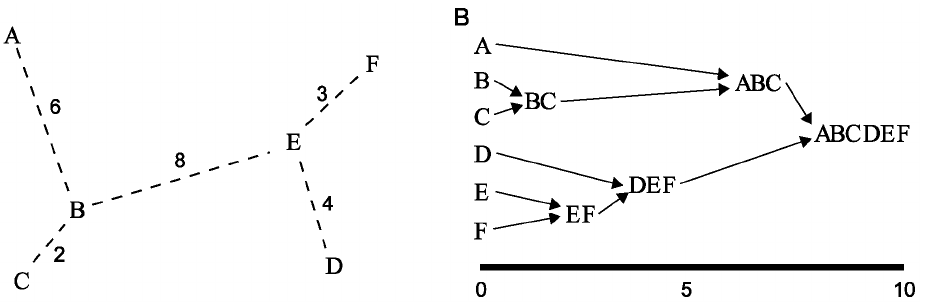
Figure 2. Graphical representation of hierarchical clustering. Hierarchical clustering sequentially clusters together elements of a set, based on inter-element distances. (A) Representation of a set of six elements. Shown is a minimal spanning tree: the tree that connects all elements minimizing total distance. (B) The clustering provided by hierarchical clustering when using single linkage clustering. Sequentially, the two current subsets with smallest distance are joined together, where the initial subsets are the six elements. This means the distances of clustering on the x-axis in (B) are the distances of the minimal spanning tree in (A). In total five distinct clusters are passed before all elements cluster together.